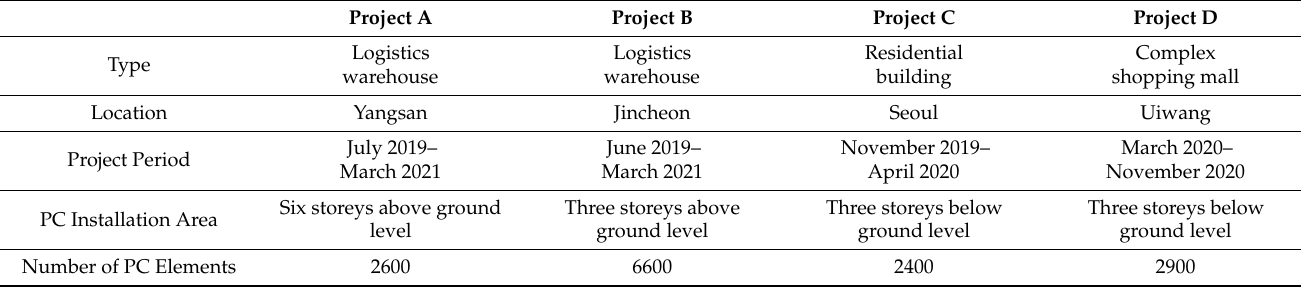
Table 1. Project